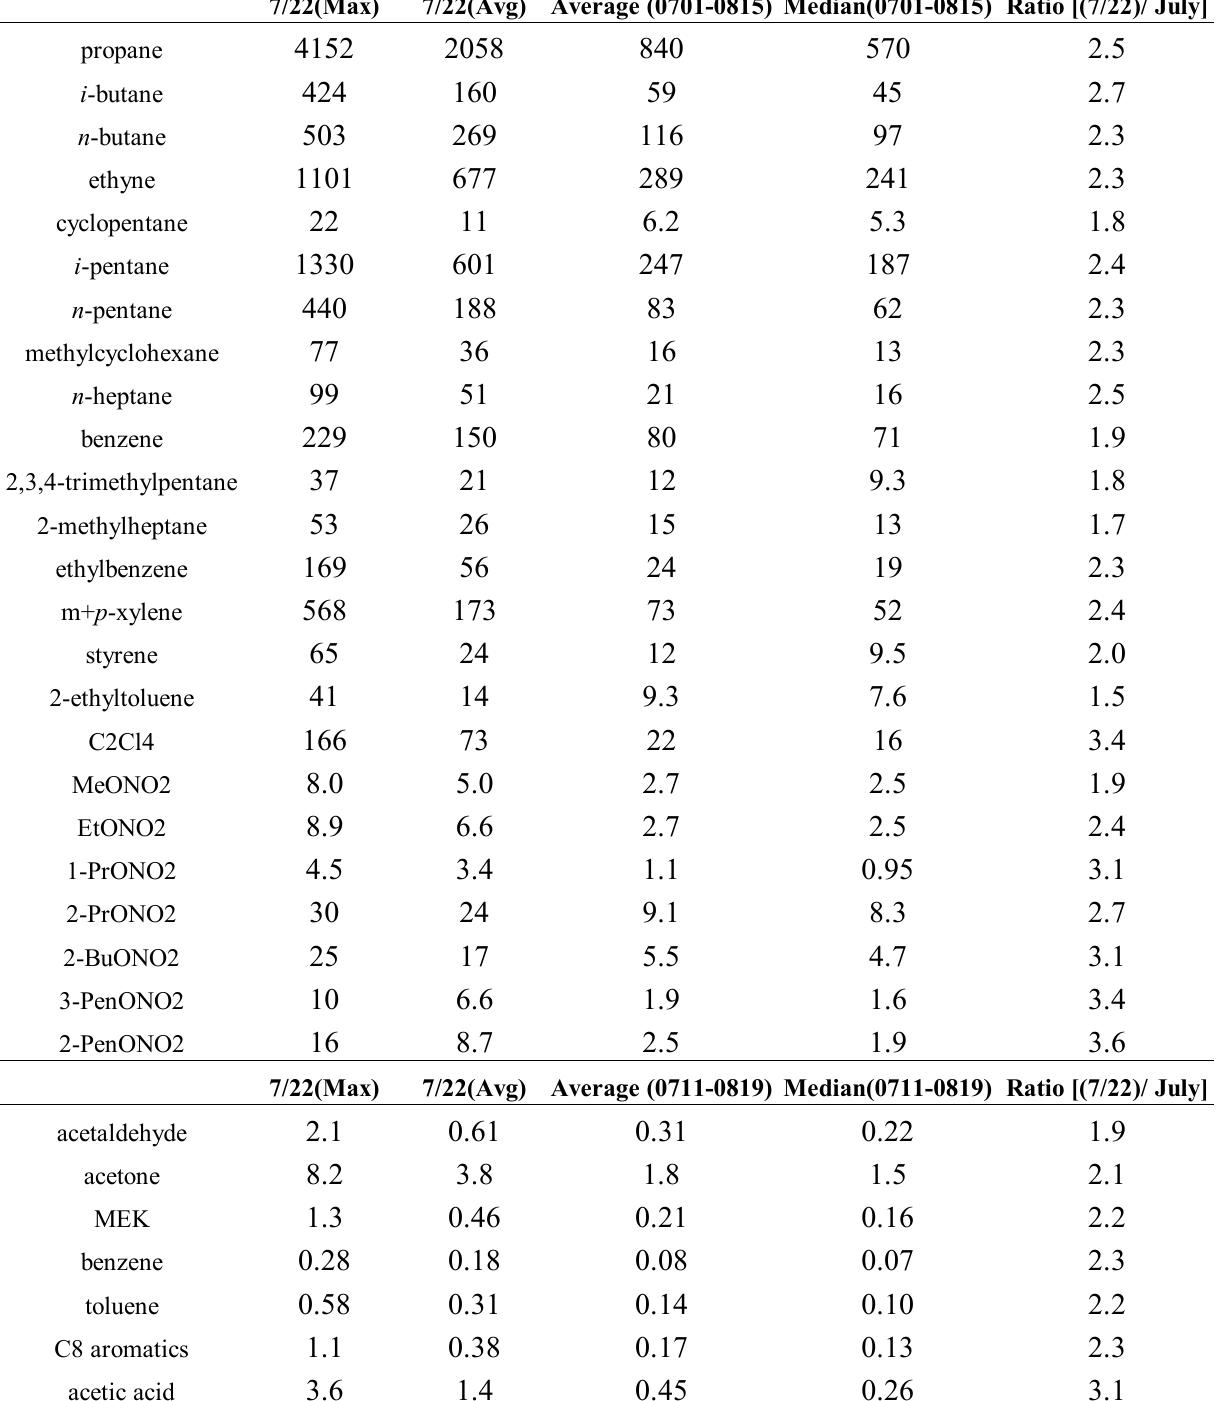
Table 2. VOC measurements at TF in 2004. The statistic values include the maximum on 7/22 (1 st column), the averages on 7/22 (2 nd column), the averages during 7/1~8/15 (3 rd column), and the median values during 7/1~8/15(4 th